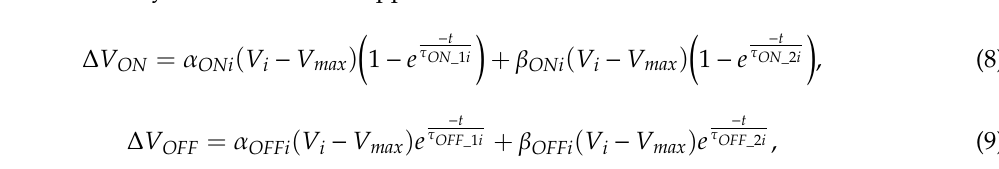
Figure 7. PMS voltages for LICEF C-03 when a constant noise source is introduced. In green, the status of the heater is depicted. Red crosses for the PMS voltage indicate that the heater is on and blue crosses show when the heater is off.